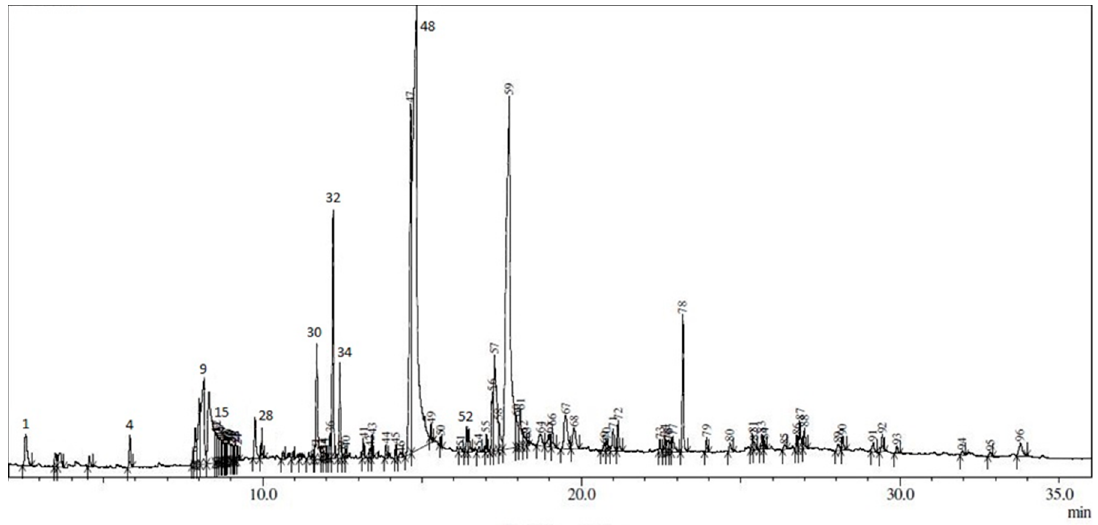
Figure 1. GC chromatogram of E60.